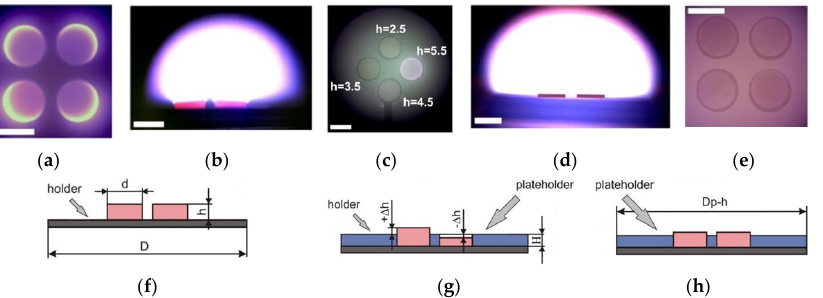
Figure 7. Top view ( a ) and side view ( b ) of the samples in an open substrate holder during the first series of growth of CVD diamond; top view ( c ) of the substrates with different heights in the holder holes during the second series of growth of CVD diamond; and side view ( d ) and top view ( e ) of substrates with equal heights in the holder during the third series of growth of CVD diamond. Schematic views of the arrangement of the substrates in the open holder (h/d = 0.45) during the first series of growth of CVD diamond ( f ); the same for the close-type holder with substrates of different heights during the second series of growth of CVD diamond ( g ), and the same for the open holder (h/d = 0.45) during the third series of growth of CVD diamond ( h ). The plate holder diameter is Dp–h = 57 mm, and the height is H = 3.5 mm. White scale bars size in the lower left corner of sub-figures ( a – e ) is 10 mm [17].